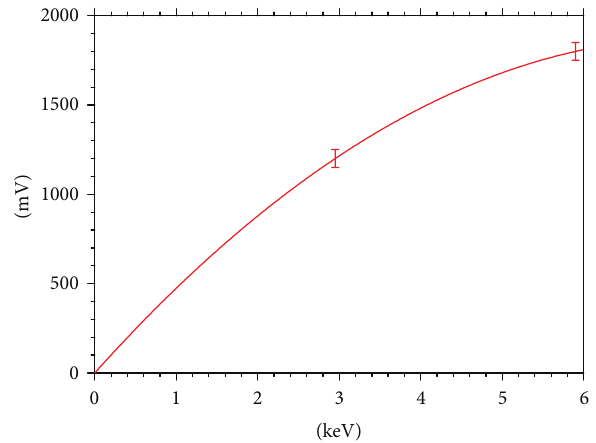
Figure 7: An observed amplitude of the pulse as a function of